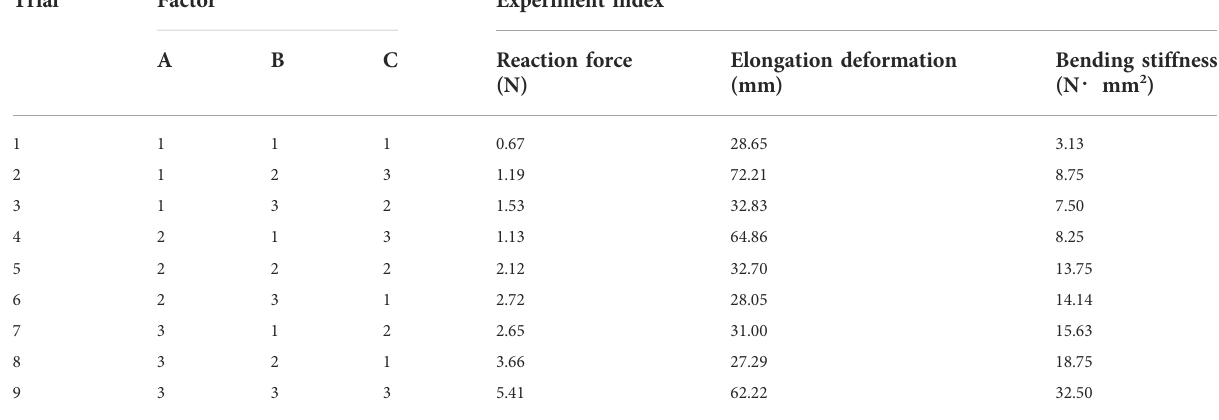
TABLE 4 Results of the orthogonal test of the nasal